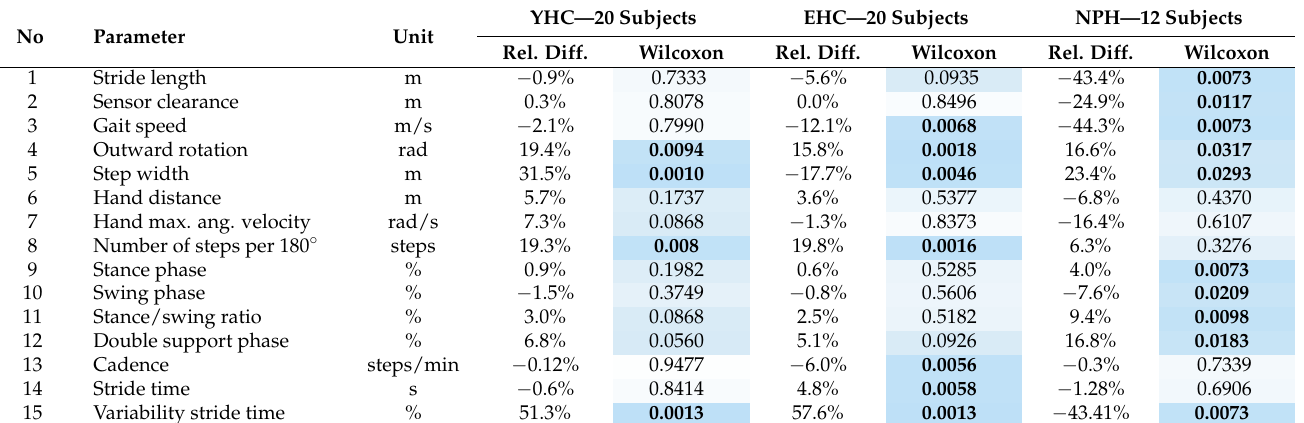
Table 1. Resulting relative differences and p -values from Wilcoxon signed rank test comparing the gait parameters of all three subject groups in controlled and real-world environments. Significant results are indicated in bold, with blue representing values closer to 0 and white representing values closer to